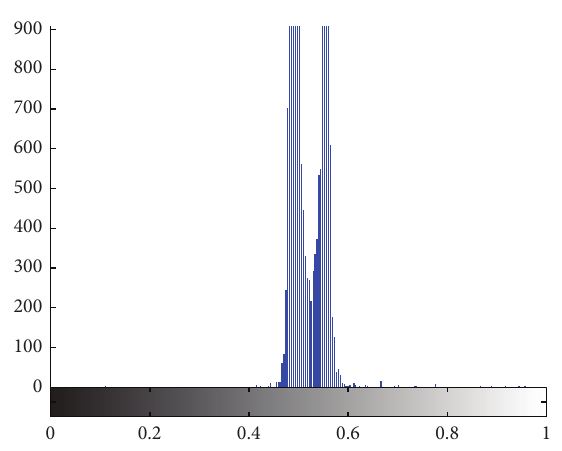
Figure 8: Hue histogram after